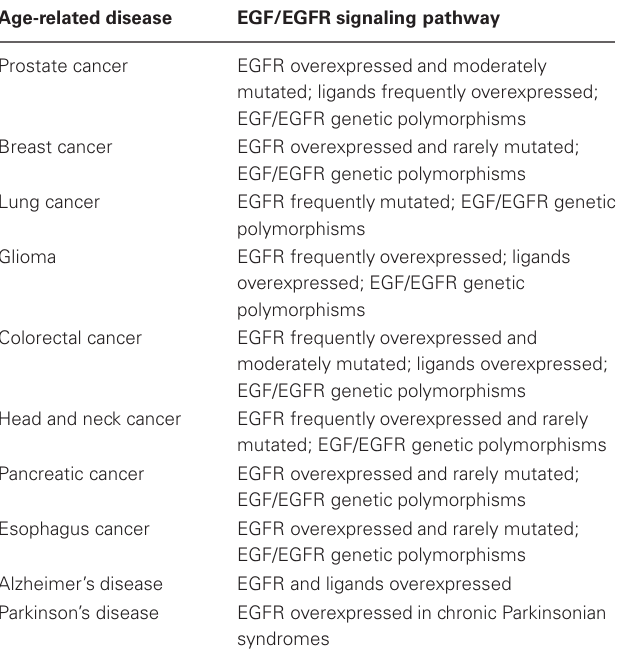
Table 1 | Alterations of components of the EGFR signaling pathway in age-related